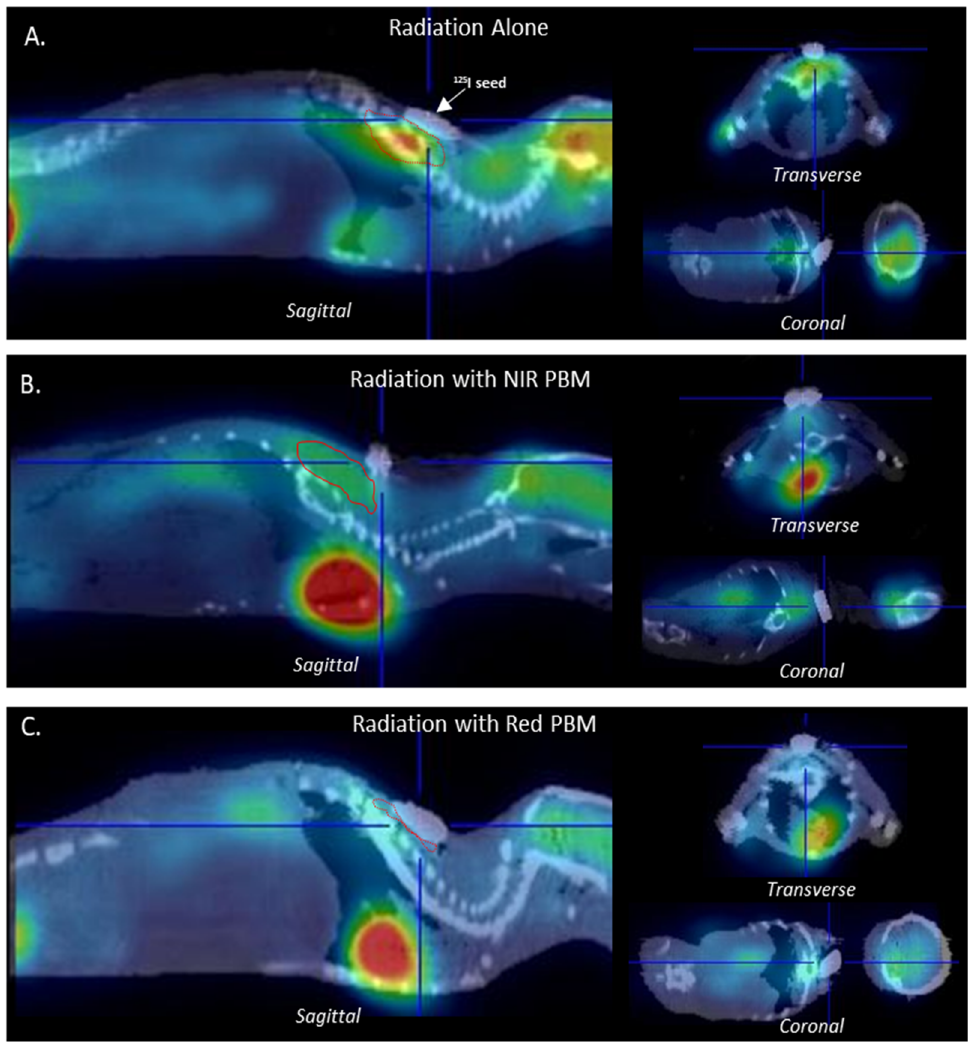
Figure 5. Fused images from CT and µ PET to examine metabolic changes in radiation alone ( A ), NIR PBM treated radiation group ( B ), and red PBM treated radiation group ( C ). The 125 I seed is shown as a radiopaque, while the areas of 18 F-FDG uptake are outlined in areas below the seed with a red dotted line.